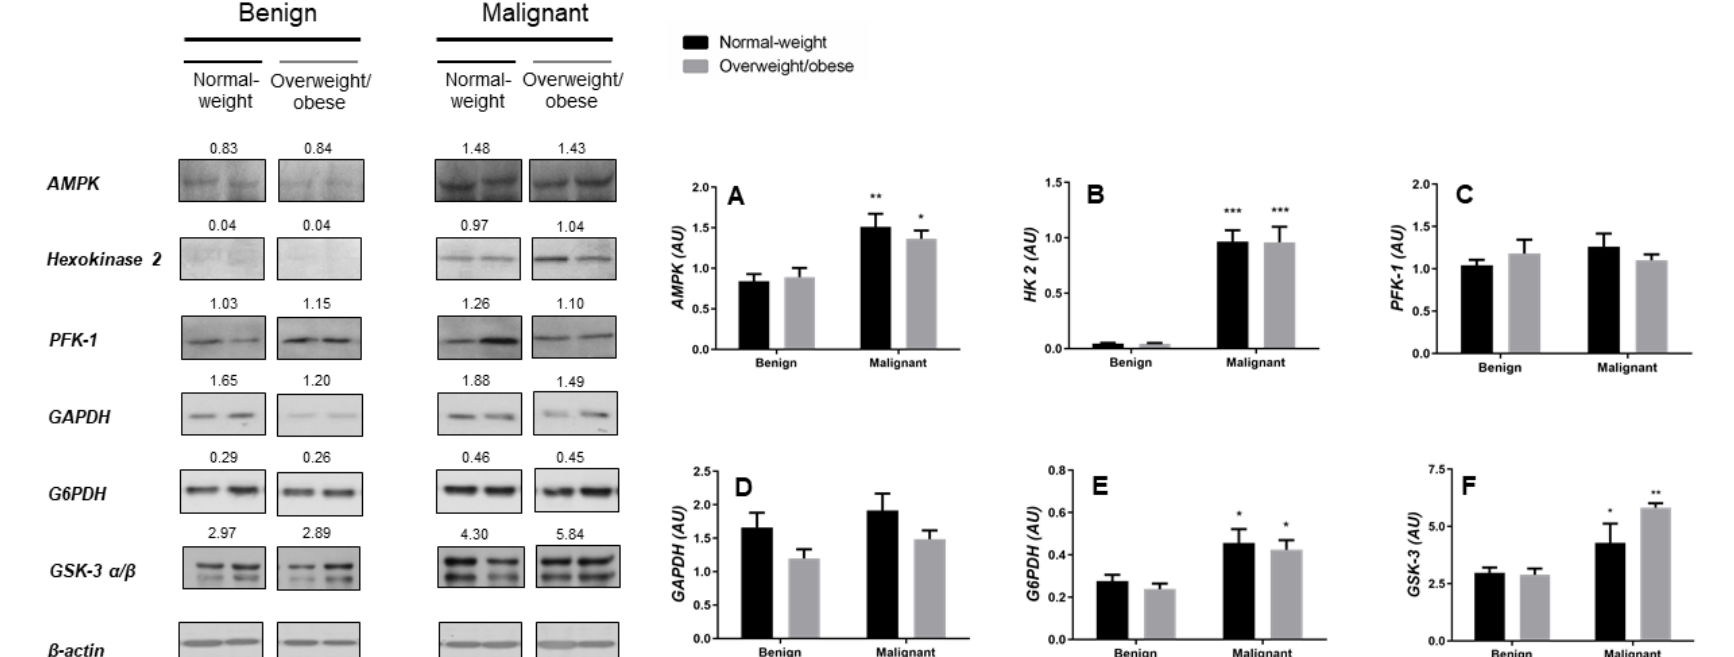
Figure 2. Breast cancer-associated adipose tissue changes in glucose metabolism irrespective of obesity. Protein expression of 5′-AMP-activated protein kinase (AMPK, A ), hexokinase 2 (HK 2, B ), phosphofructokinase (PFK-1, C ), glyceraldehyde-3-phosphate dehydrogenase (GAPDH, D ), glucose-6-phosphate 1-dehydrogenase (G6PDH, E ), and glycogen synthase kinase-3 (GSK-3 α/β, F ) in benign and malignant tumor-associated adipose tissue of normal-weight (black) and overweight/obese (gray) women. The protein content is normalized to β-actin levels and expressed in arbitrary units (AU); mean values of densitometric analysis for each group are shown above respective bands. Two representative band images cut from the same blot are shown for each group ( n = 9); each band is representative of three pooled samples. Images of whole uncut blots with values of densitometric analysis for each band are shown Figure S1. Bars represent the average values ± S.E.M. * Comparison to respective benign counterpart, * p < 0.05, ** p < 0.01, *** p < 0.001.